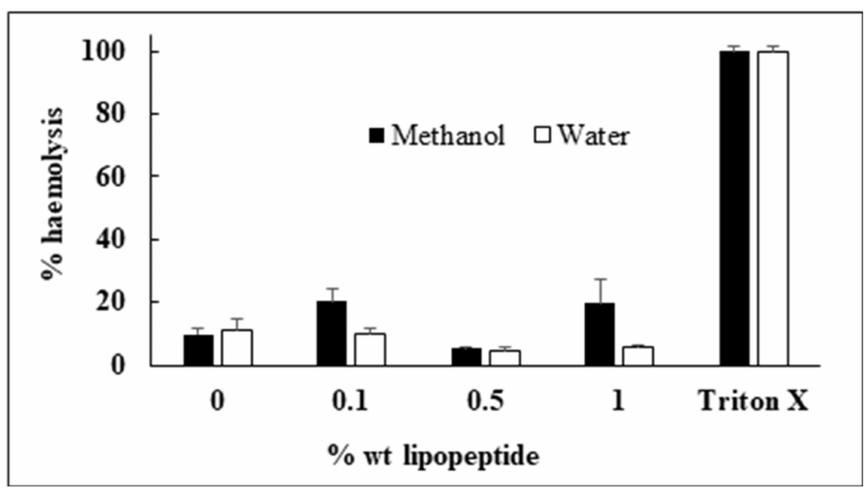
Figure 6. Percentage haemolysis of mouse blood cells by the gels prepared in methanol and